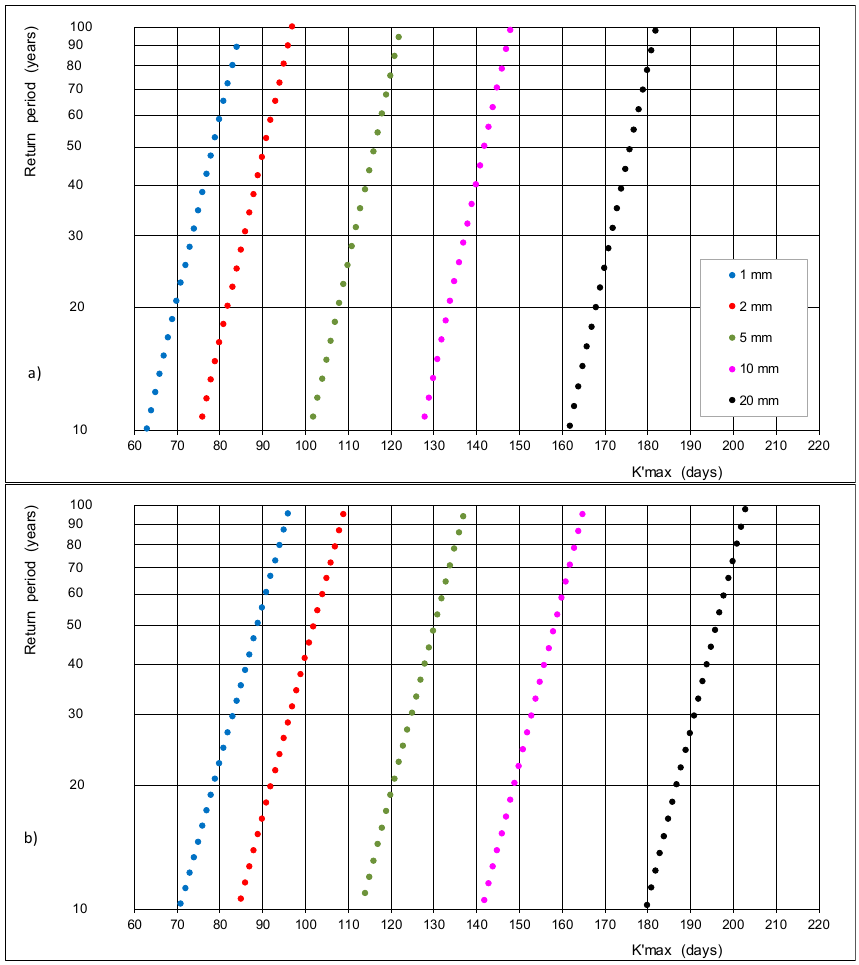
' k (days) for different 30-year periods and max